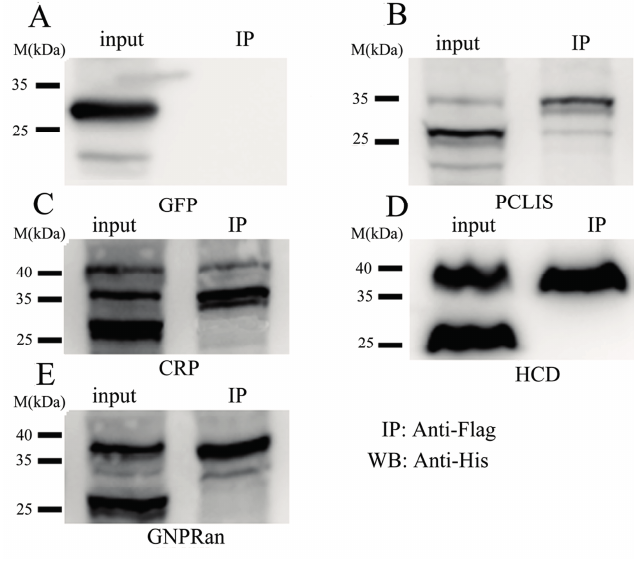
Figure 3. Confirmation of SUMOylated proteins by co-immunoprecipitation (co-IP). Flagged-SUMO and His-tagged polyubiquitin- C -like isoform X1 (PCLIS), 3-hydroxyacyl-CoA dehydrogenase (HCD), cyclin-related protein FAM58A-like (CRP) and GTP-binding nuclear protein Ran (GNPRan) were co-expressed in Drosophila S2 cells. Cell lysates were immunoprecipitated with anti-Flag magnetic beads and analyzed by western blotting using anti-His antibody. ( A ) GFP; ( B ) PCLIS; ( C ) CRP; ( D ) HDC; ( E )